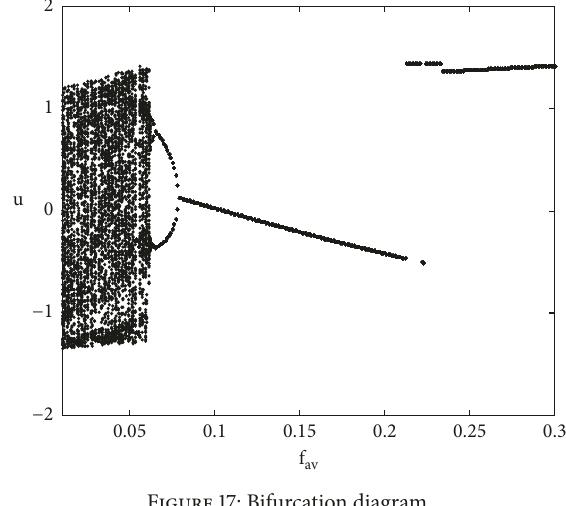
Figure 17: Bifurcation diagram.